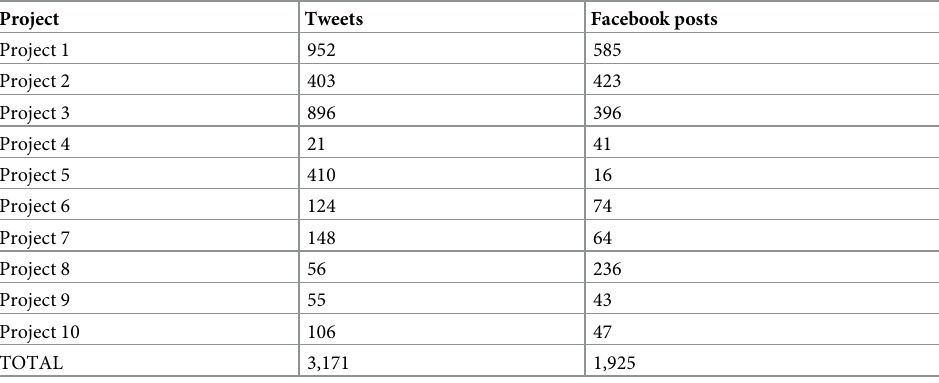
Table 3. Tweets and Facebook posts per project obtained–Strategy